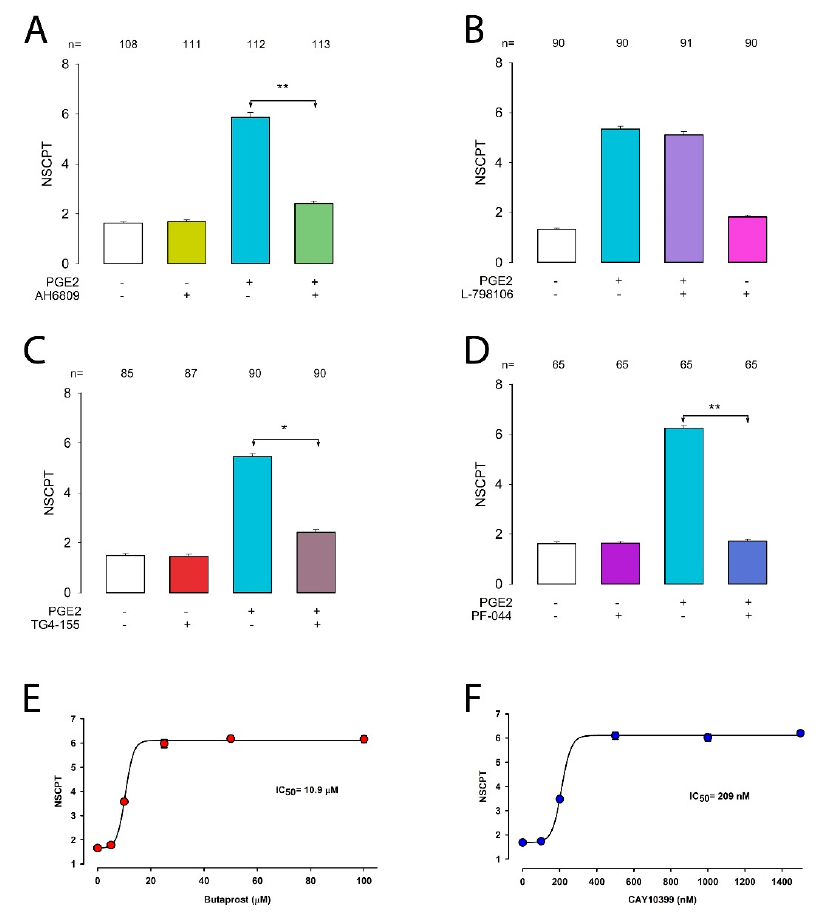
Figure 5. Prostaglandin E2 enhances GJIC via the EP2 receptor. ( A – D ) The effect of EP receptor antagonists. Bar charts compare the mNSCPT ( ± SE) of the given experimental condition indicated below each bar. The numbers above bars indicate the number of repeats. The * and ** symbols indicate a statistically significant difference ( p < 0.01) and ( p < 0.001) respectively between the bars, indicated by the lines. ( E , F ) Dose–effect plots show the effect of EP2-selective agonists butaprost and CAY10399, respectively. The continuous lines were calculated from fitting data to a sigmoidal 4-parameter model to obtain IC50.